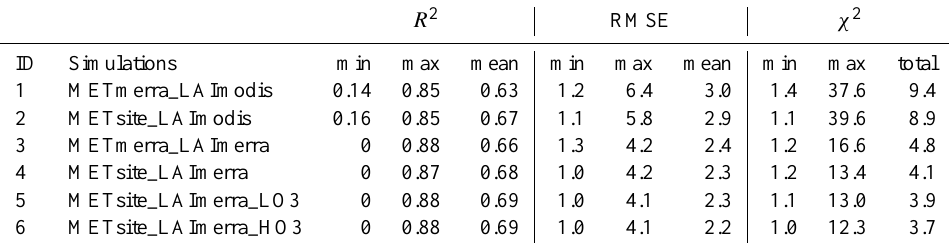
Table 3. Statistics ∗ for site-level simulations.